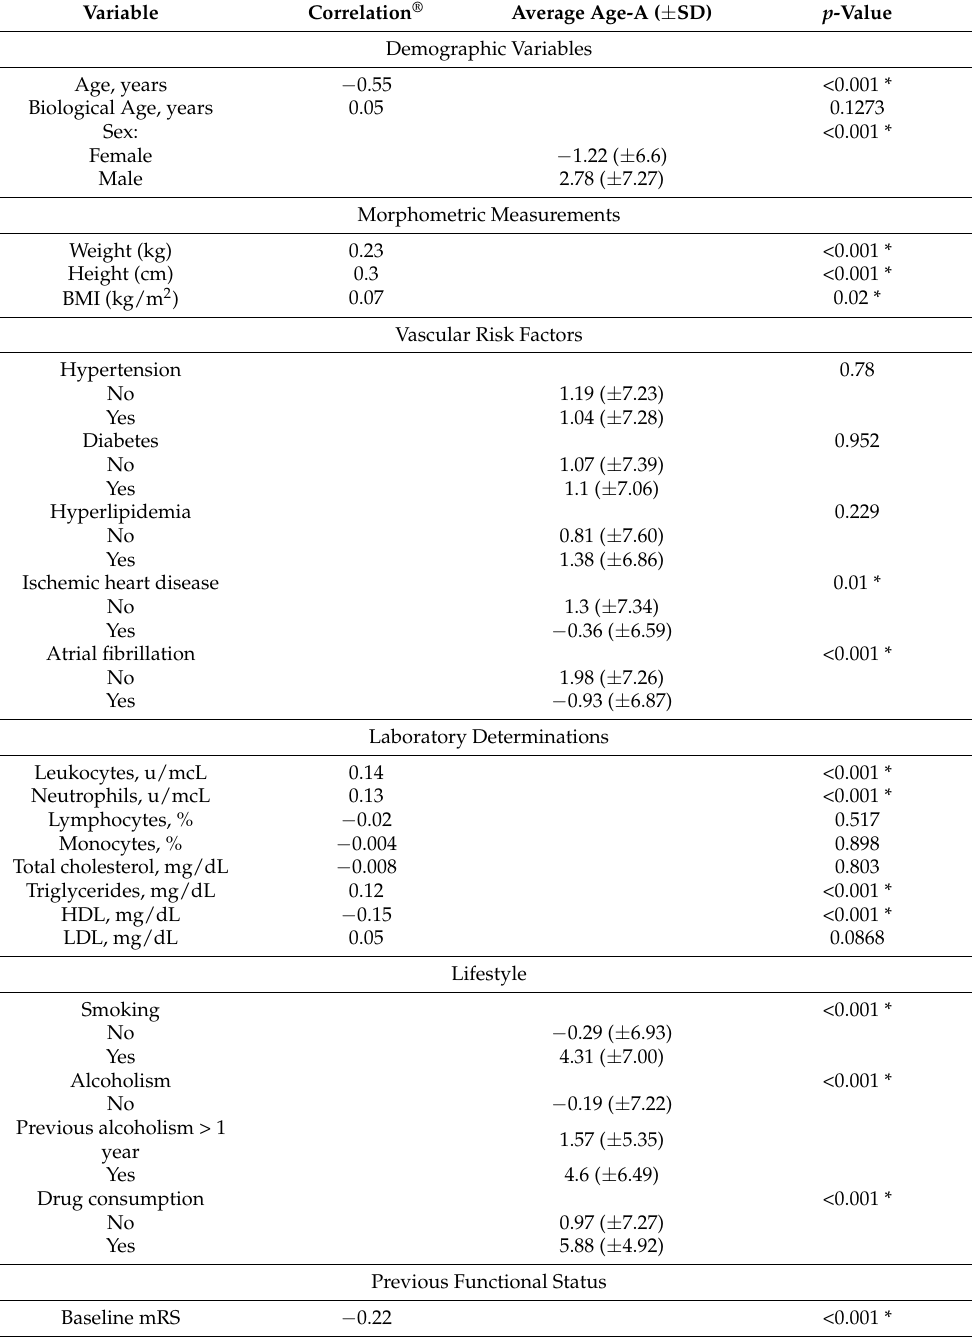
Table 2. Bivariate associations between predictors of interest and age